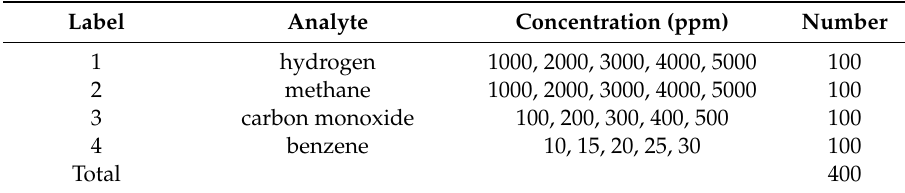
Table 1. Dataset in detail.